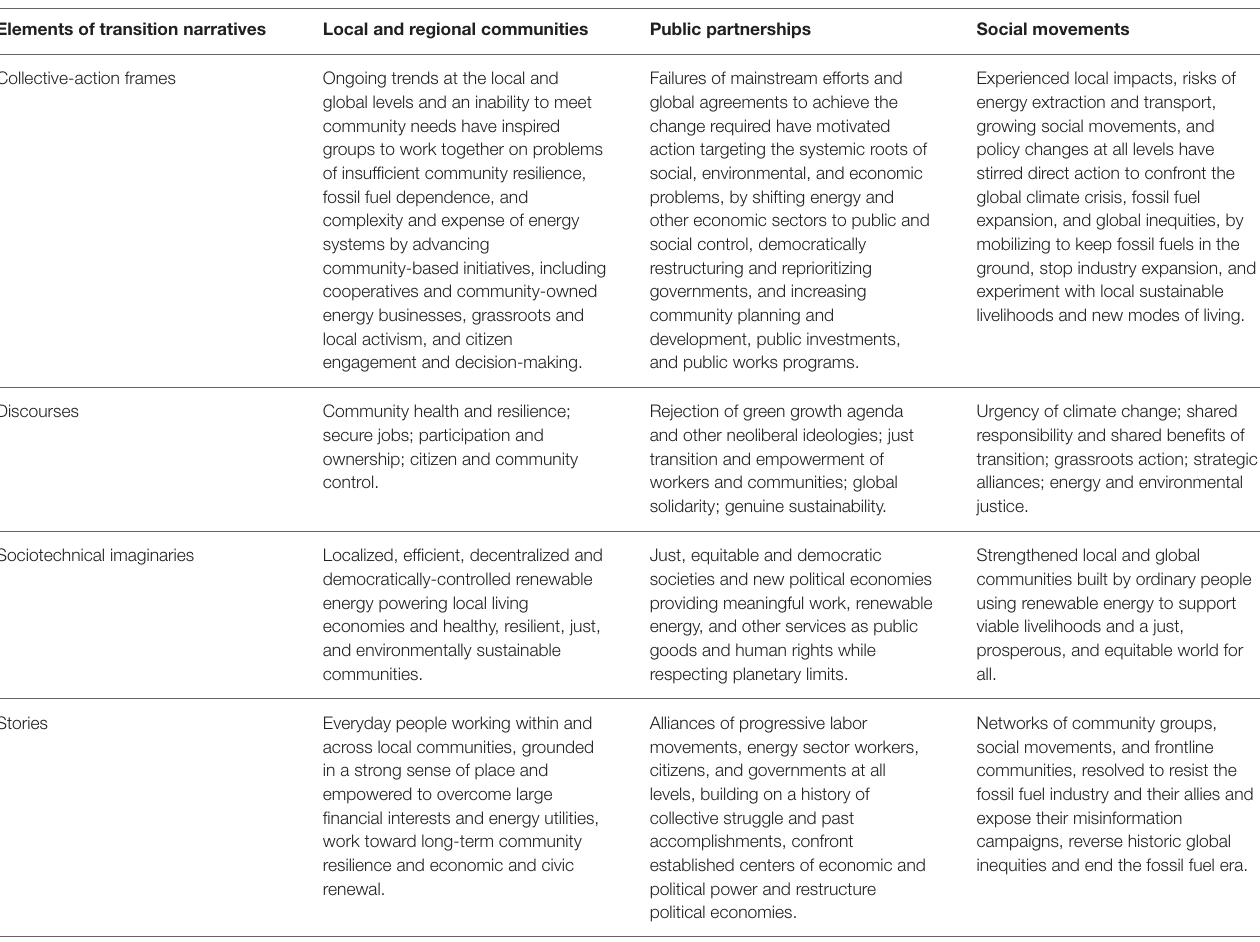
TABLE 3 | Comparative summary of variants of energy democracy transition